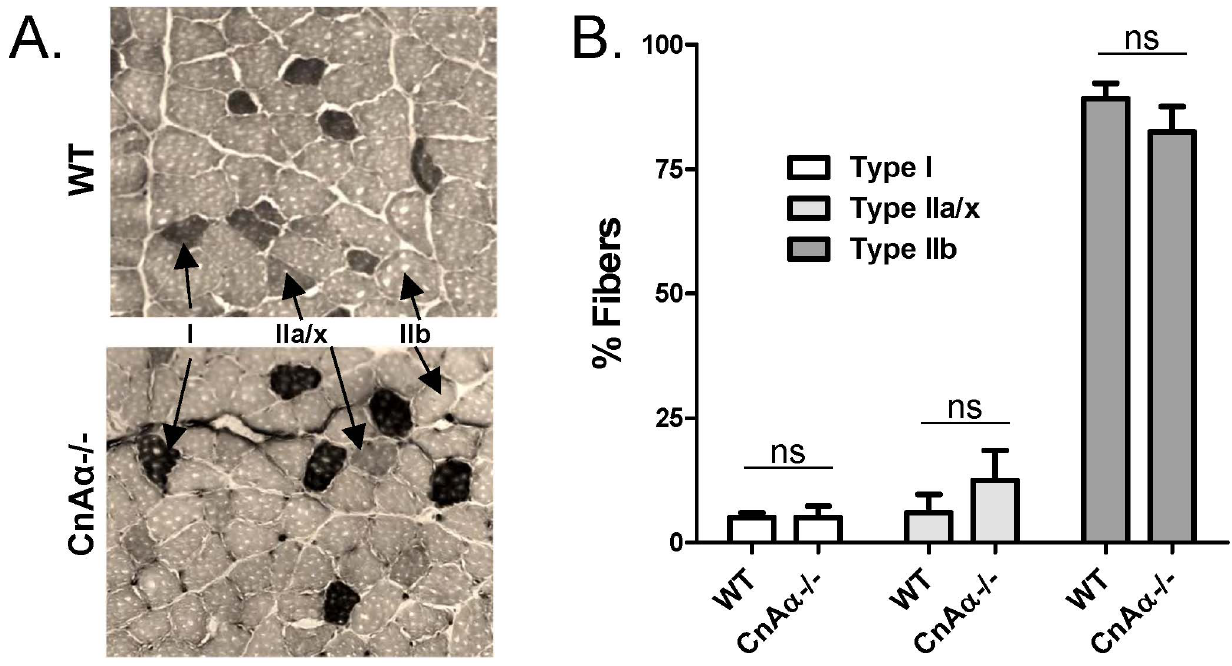
Figure 5. Fiber type distribution of CnA a 2 / 2 skeletal muscle is normal. A) Gastrocnemius muscle samples were fixed and stained with NADH-tetrazolium. Typically appearing type I, IIa/x, and IIb fibers are indicated with arrows on each panel. Data shown are representative of 6 mice per group. B) The distribution of type I, IIa/x, and IIb fibers were quantified and graphed. The data shown are the mean 6 SEM of 6 mice per group.